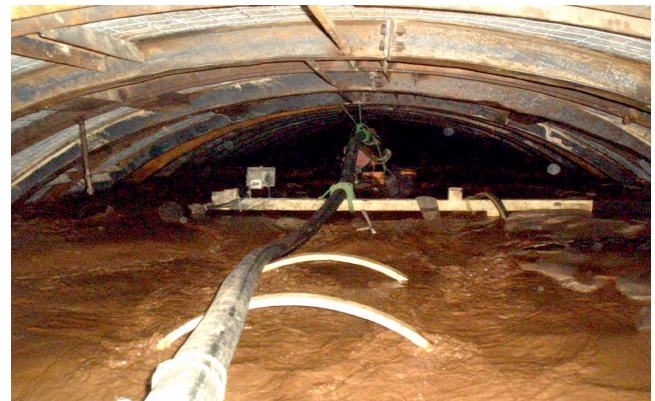
Figure 14. TBM buried in silt in the head race tunnel of PHPP-II (Source: Clark and Chorley